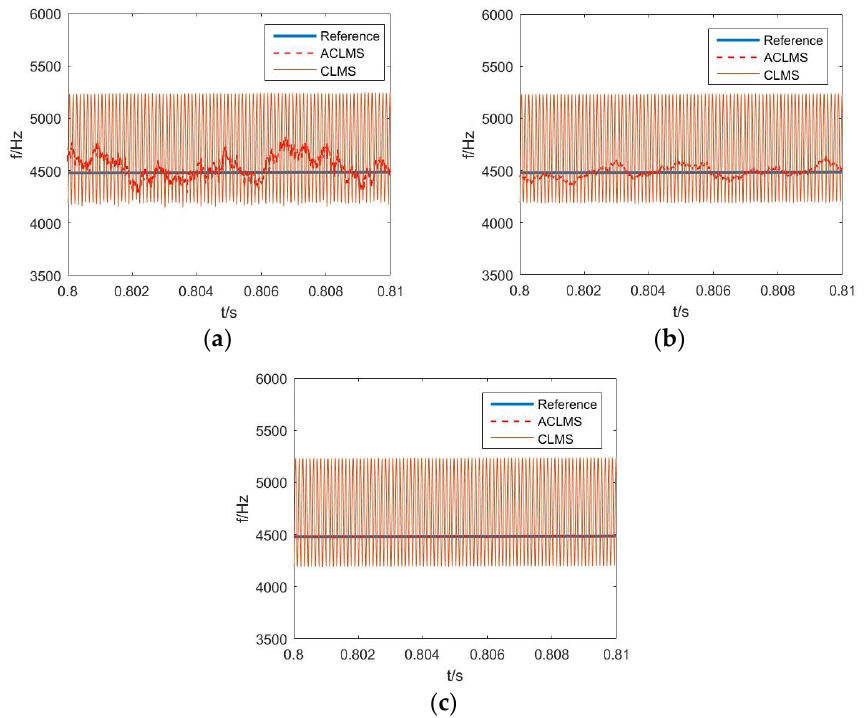
Figure 4. Frequency estimation based on ACLMS and CLMS: ( a ) SNR = 27 dB; ( b ) SNR = 37 dB; ( c ) SNR = 57dB.